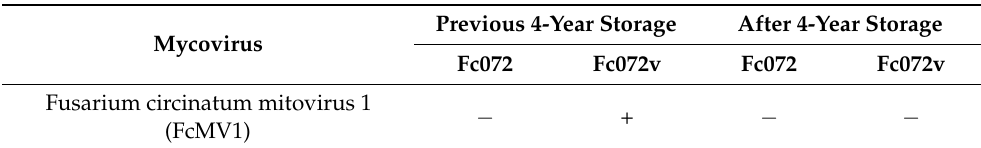
Table 1. Presence (+) or loss/absence ( − ) of the mitovirus FcMV1 of Fusarium circinatum , detected by polymerase chain reaction (PCR).